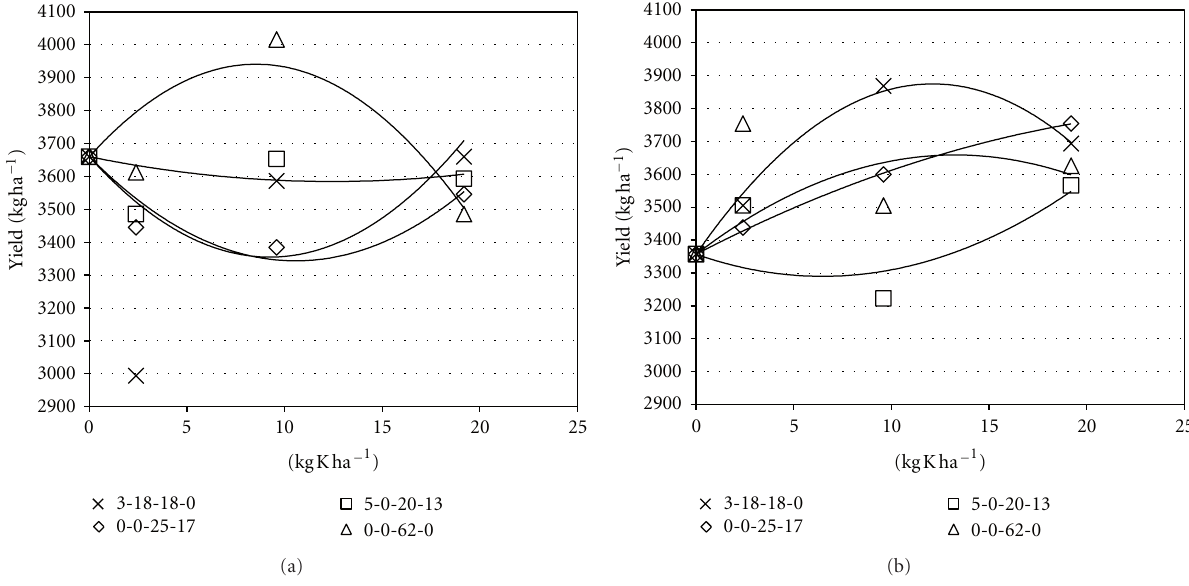
Figure 4: Soybean grain yield response to K-fertilizer additives (%N-%P 2 O 5 -%K 2 O-%S) of 3-18-18-0 ( y = 63 . 659 x 2 − 66 . 085 x + 3660, R 2 = − 0 . 07), 0-0-25-17 ( y = 12 . 81 x 2 − 59 . 903 x + 3660, R 2 = 0 . 79), 5-0-20-13 ( y = 17 . 383 x 2 − 12 . 125 x + 3660, R 2 = − 0 . 34), or 0-0-62- 0 ( y = 16 . 945 x 2 + 65 . 878 x + 3660, R 2 = 0 . 74) applied alone to weed-free plots (a) and with glyphosate to weedy plots (b) for 3-18-18-0 ( y = 0 . 628 x 2 +85 . 563 x +3357, R 2 = 0 . 99), 0-0-25-17 ( y = − 1 . 6925 x 2 +30 . 832 x +3357, R 2 = 0 . 99), 5-0-20-13 ( y = − 19 . 902 x 2 − 20 . 694 x +3357, R 2 = 0 . 40), and 0-0-62-0 ( y = − 35 . 635 x 2 + 45 . 506 x + 3357, R 2 = − 0 . 24) at Malden in 2004 and 2005. Data were combined over years, and comparisons between figures are valid. The nontreated, weed-free, and glyphosate plus nonionic surfactant plus diammonium sulfate grain yields were 3230, 3660, and 3570 kg ha − 1 , respectively. There were no significant di ff erences among treatments ( P = 0 . 81) at this